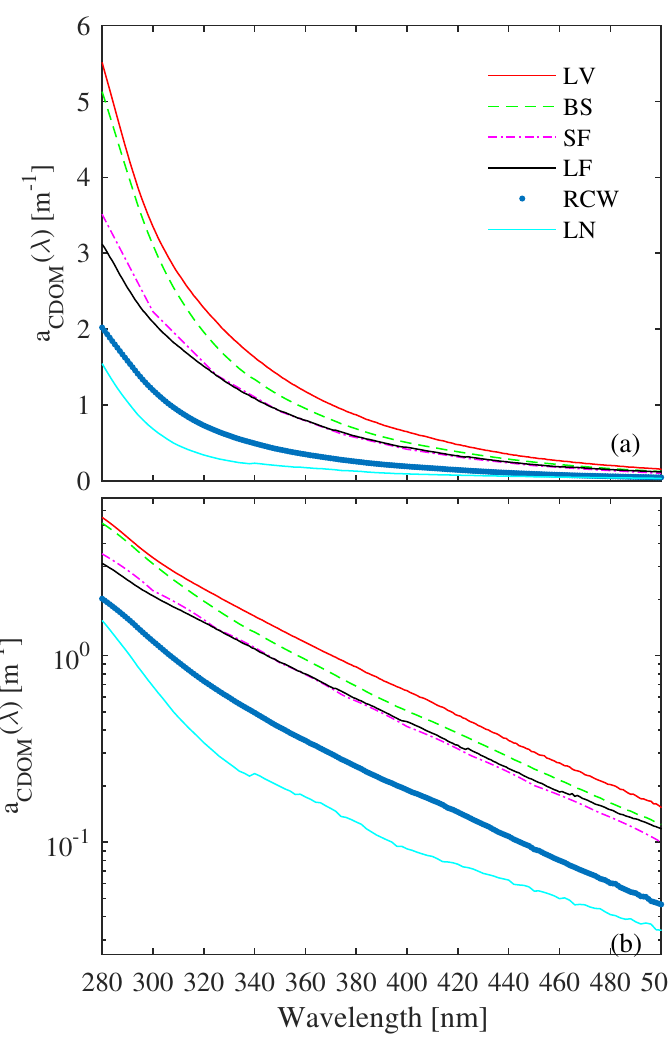
Figure 2. ( a ) Mean colored dissolved organic matter (CDOM) absorption spectra for different locations. ( b ) Semi-log plots of the CDOM absorption spectra in ( a